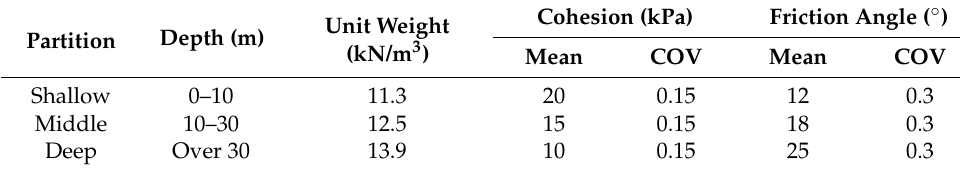
Table 6. The geotechnical characteristics of the MSW landfill